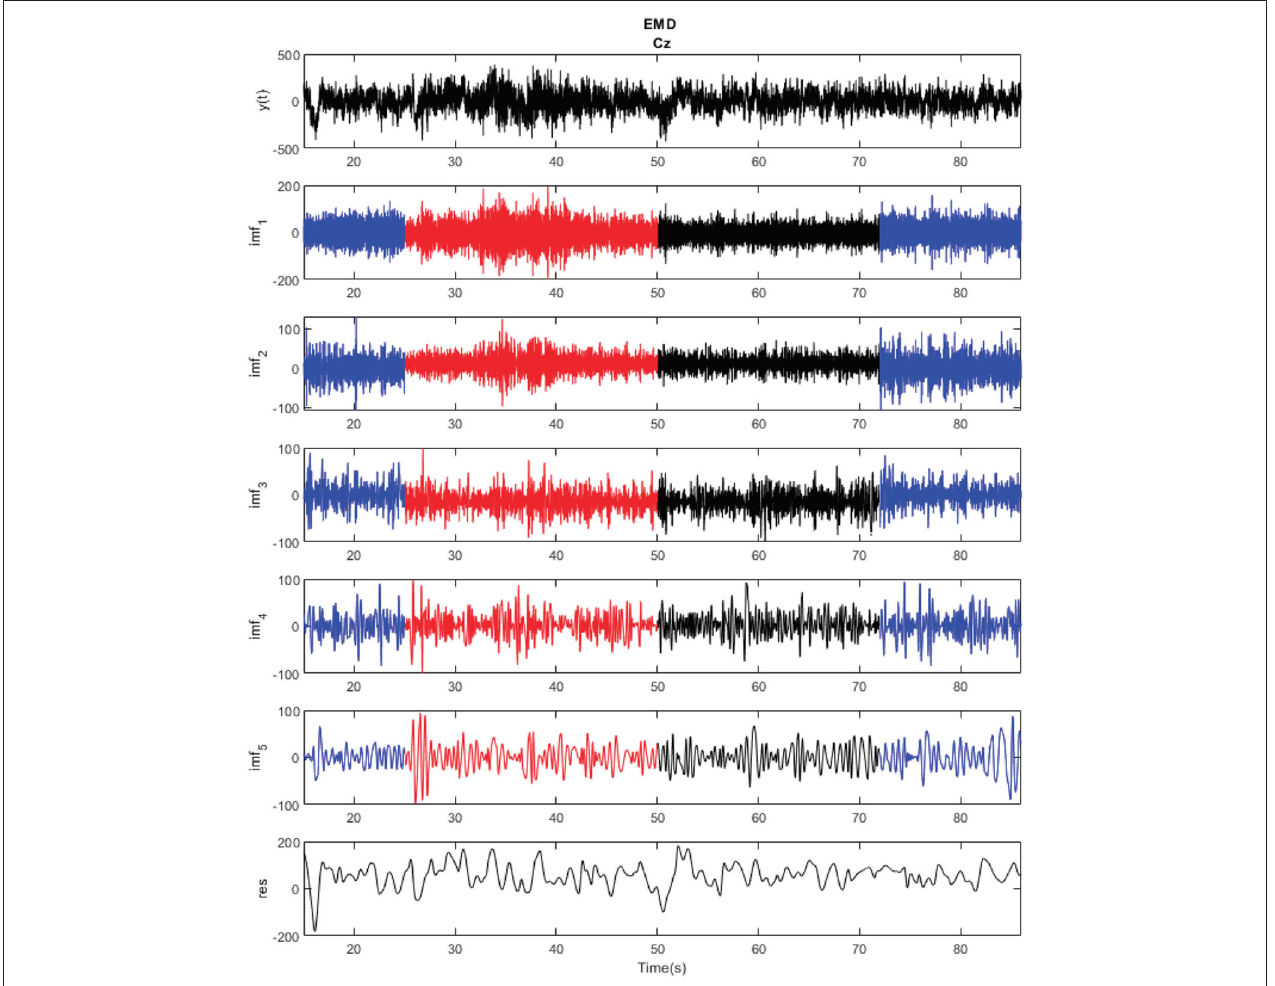
FIGURE 3 | Empirical mode decomposition of one of the trials of subject S2 for Cz electrode. MI periods appear in red and relaxed state periods in blue. Each of the modes corresponds to the local oscillations of the signal in descendent value of